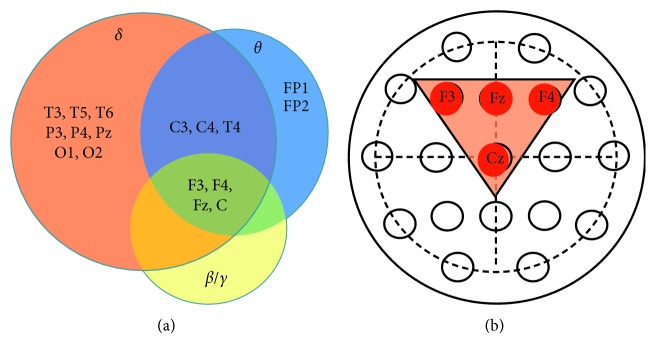
Venn diagram analysis to identify specificity of electrodes in which spectral powers were altered in patients with opioid use disorder. (a) The brown circle indicates δ-specific electrodes, the blue circle for θ-specific electrodes, and the yellow for β/γ-specific electrodes. (b) Topographic location of electrodes showing increases in δ, θ, β, and γ powers.